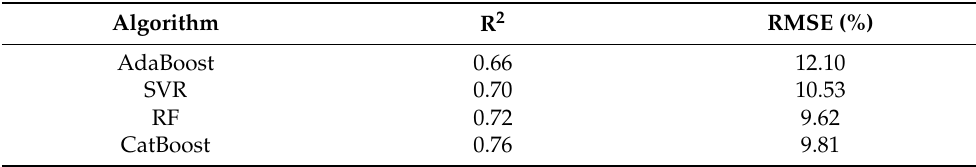
Table 2. Comparison of R 2 and RMSE of different algorithms.